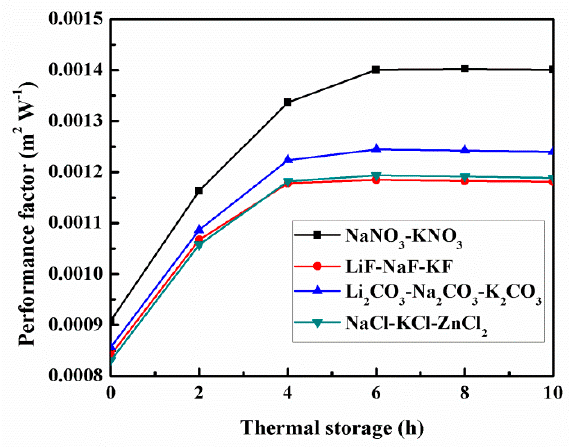
Figure 6. Influence of TES capacity on the performance factor for four different molten-salts.